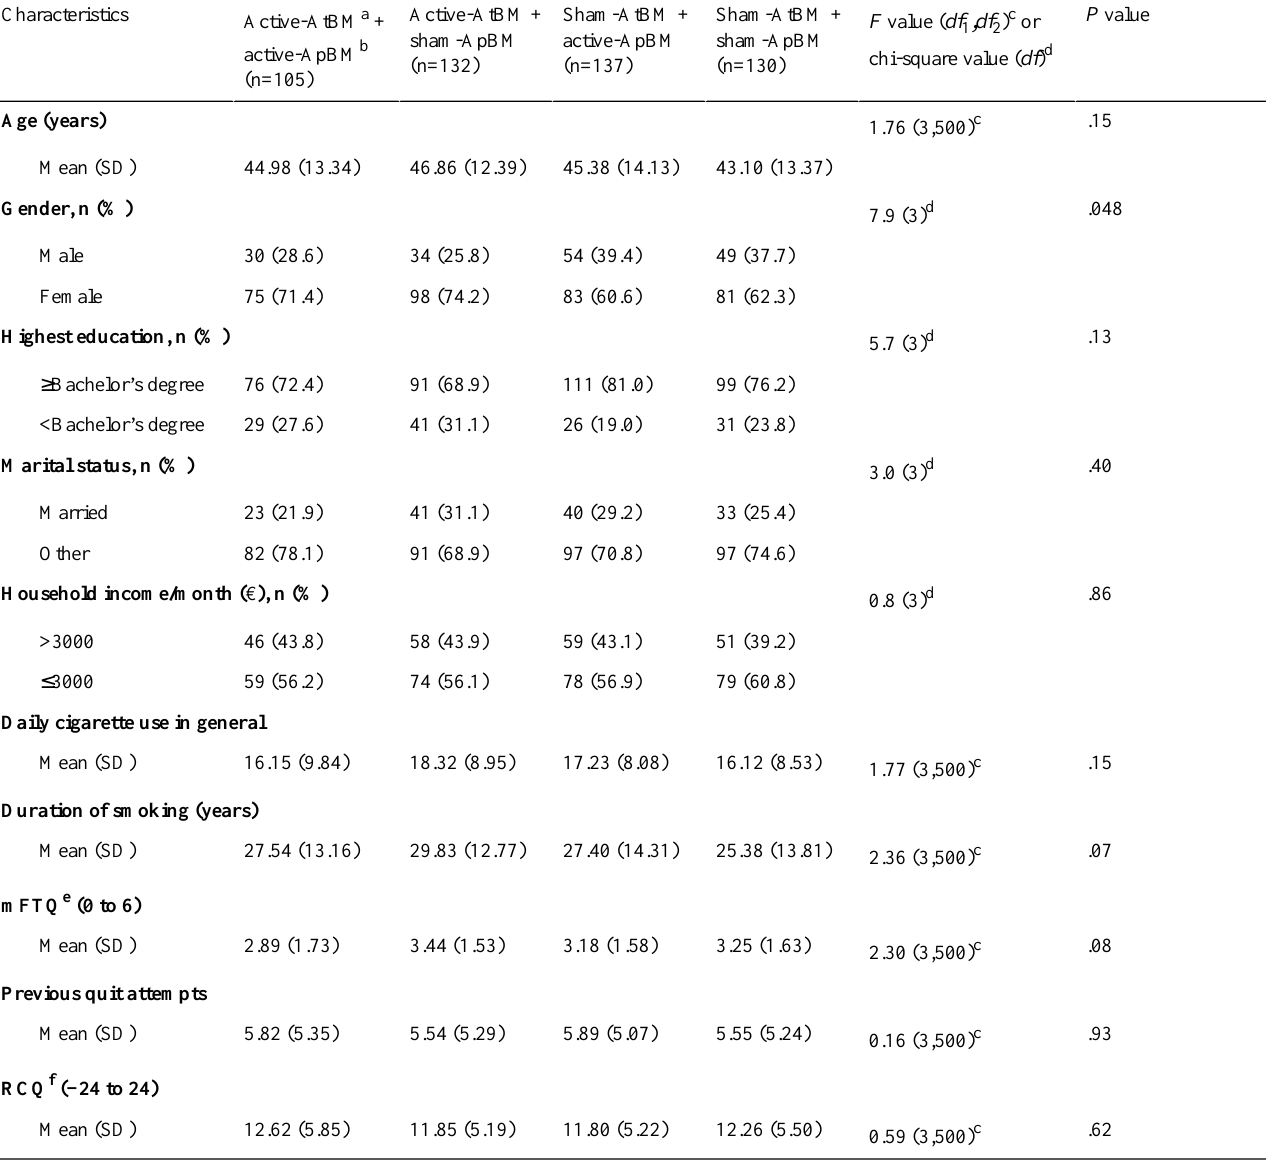
Table 1. Baseline characteristics of the final sample per